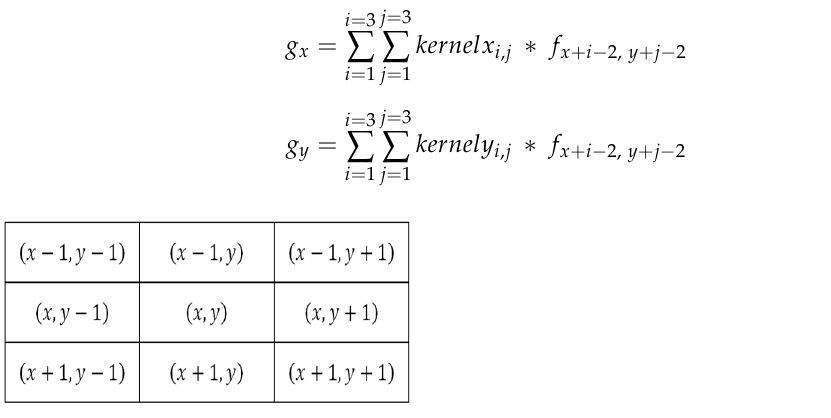
Figure 1. Coordinates of the input image f